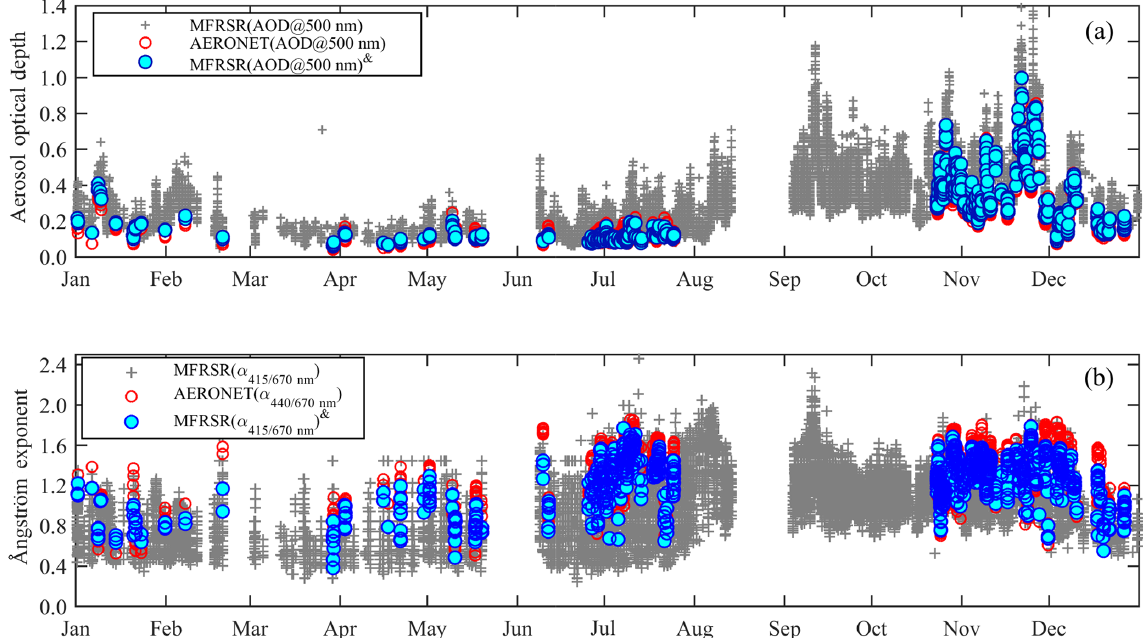
Figure 4. Seasonal variability of (a) aerosol optical depth and (b) the Ångström exponent (AE) in the visible spectrum region in central Amazonia for 2012. MFRSR (AOD@500nm) represents MFRSR instantaneous AOD retrieval at 1min rate; MFRSR (AOD@500nm) & represents only MFRSR AOD retrieved that have been collocated in time with AERONET Sun photometer AOD retrieval (AERONET (AOD@500nm)). MFRSR ( α 415 / 670nm ) represents MFRSR instantaneous AE at 1min rate; MFRSR ( α 415 , 670nm ) & represents only MFRSR AE retrieved that have been collocated in time with AERONET Sun photometer AE retrieval (AERONET ( α 440 , 670nm )).